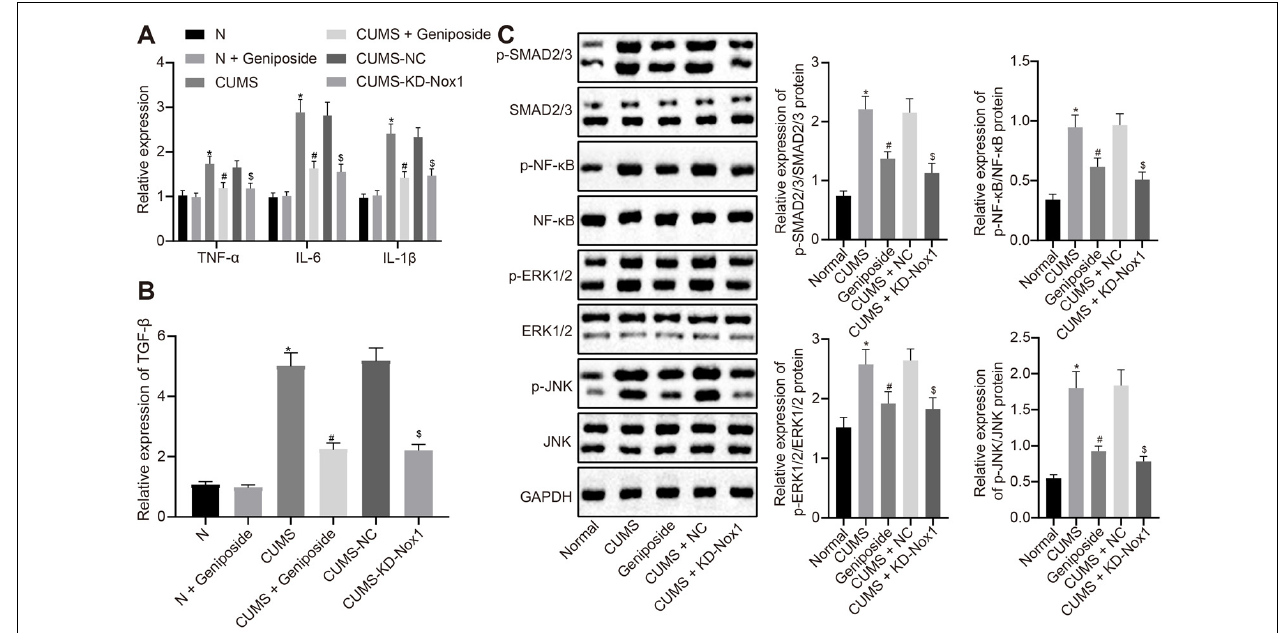
FIGURE 3 | Geniposide reduced oxidative stress in CUMS mice by reducing ROS production and inflammation. (A) The levels of TNF- α , IL-1 β and IL-6 mRNA in frontal cortex tissues after different treatment determined by RT-qPCR ( n = 10). The variance analysis of TNF- α level: F (5,54) = 58.46, p < 0.001. The variance analysis of IL-1 β level: F (5,54) = 153.00, p < 0.001. The variance analysis of IL-6 content: F (5,54) = 173.00, p < 0.001. (B) The TGF- β mRNA level in the frontal cortex tissues after different treatment determined by RT-qPCR ( n = 10). (C) The expression of SMAD2/3, NF- κ B, JNK and ERK1/2 and their corresponding phosphorylation in the frontal cortex tissues after different treatment ( n = 10). The variance analyses of phosphorylated SMAD2/3/SMAD2/3 protein: F (4,160) = 44.18, p < 0.001, phosphorylated NF- κ B/NF- κ B protein: F (4,88) = 35.99, p < 0.001, phosphorylated ERK1/2/ERK1/2 protein: F (4,65) = 58.39, p < 0.001, and phosphorylated JNK1/2/JNK1/2 protein: F (4,142) = 158.2, p < 0.001. * p < 0.05 vs. normal mice. # p < 0.05 vs. CUMS mice. $ p < 0.05 vs. CUMS mice treated with NC. Data were all measurement data and expressed as mean ± standard deviation. Data among multiple groups were analyzed by one-way ANOVA, followed by Tukey’s post hoc test, and the experiment was repeated three times